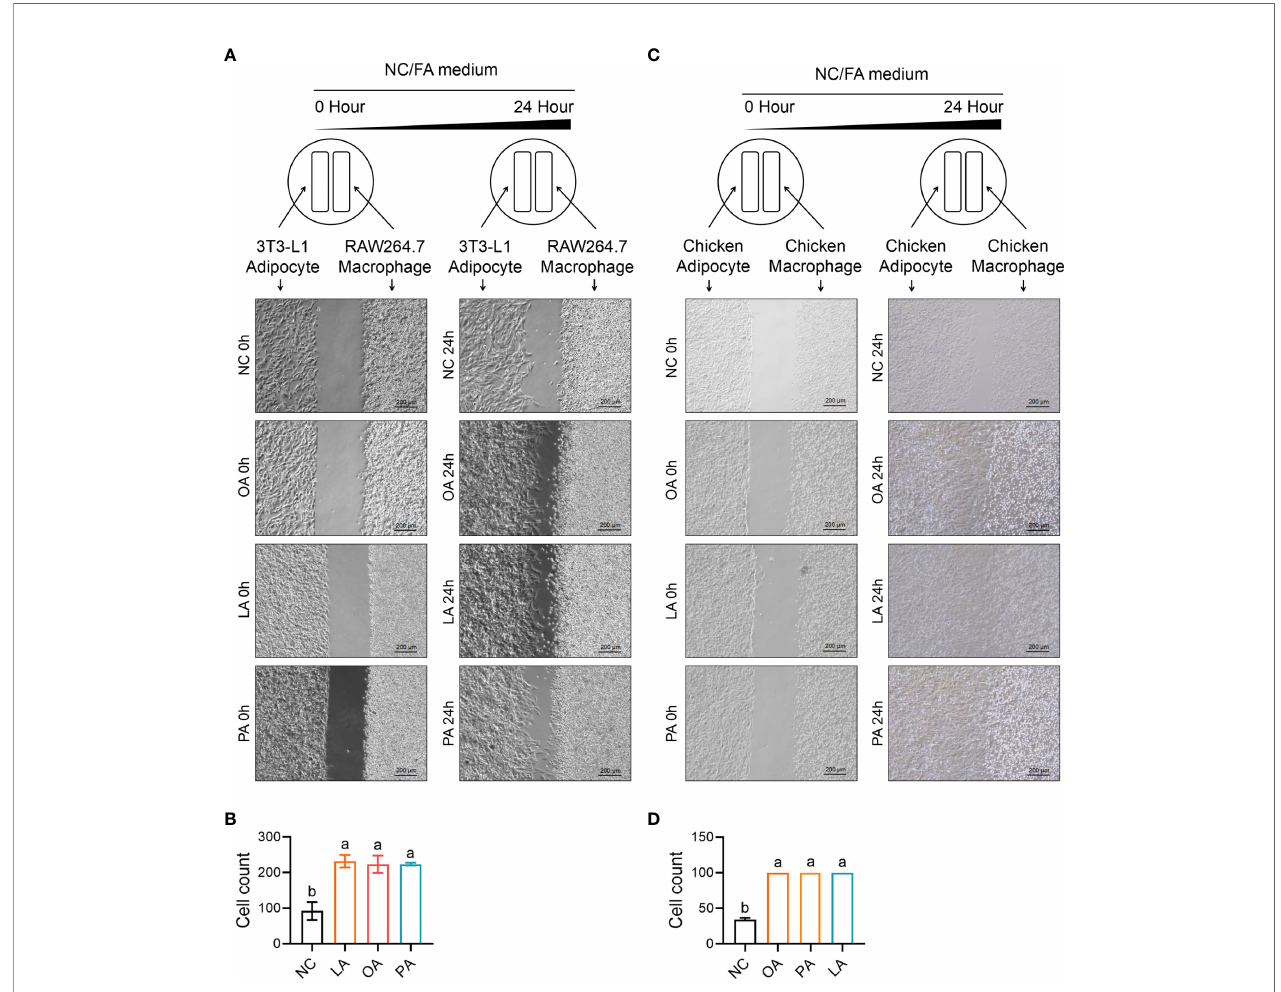
FIGURE 12 | FFA-induced cell migration (insert) between adipocyte and macrophage in chicken and mouse. (A) FFA-induced cell migration (insert) between 3T3-L1 adipocyte and RAW264.7 macrophage; (B) FFA-induced relative healing area between 3T3-L1 adipocyte and RAW264.7 macrophage for 24 h; (C) FFA-induced cell migration (insert) between chicken adipocyte and macrophage; (D) FFA-induced relative healing area between chicken adipocyte and macrophage for 24 h a,b= p